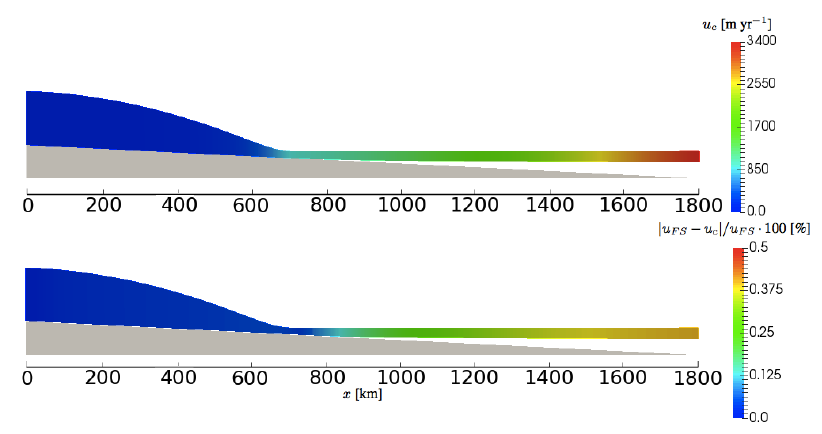
Figure 4. The coupled velocity u c (myr − 1 ) and relative difference | u FS − u c | /u FS · 100 (%), for the diagnostic MIS experiment. The bedrock is shaded in grey, x GL = 730 . 8km, and x c = 763 . 2km (the mesh resolution yields || x c − x GL || h = 32 . 4km). The vertical scale is exaggerated 100 times with an ice thickness ranging from 1435 to